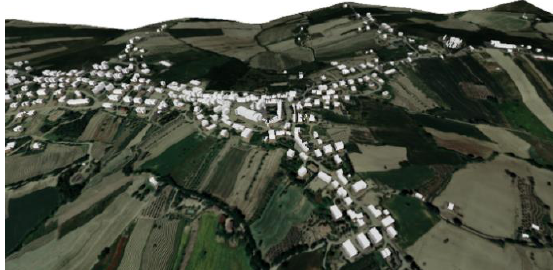
Figure 13. LOD2, Generic City